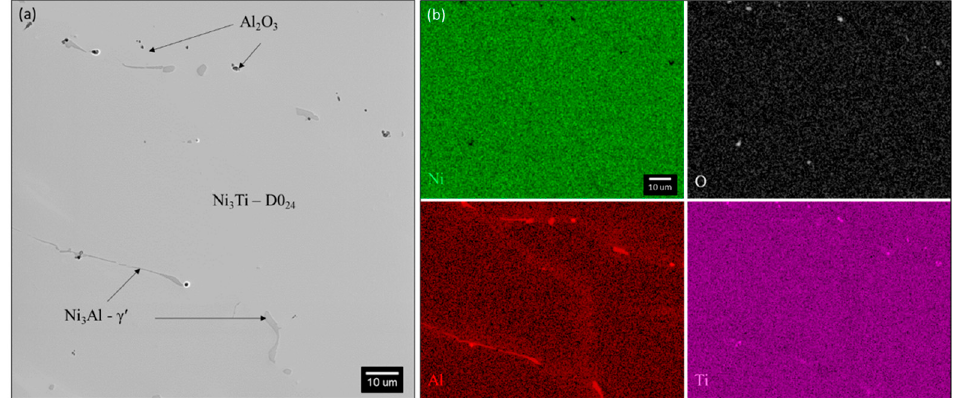
Figure 8. ( a ) SEM micrograph of the cast 79.24 wt.% Ni, 19.75 wt.% Ti, and 1.01 wt.% Al ingot and associated ( b ) chemical maps.